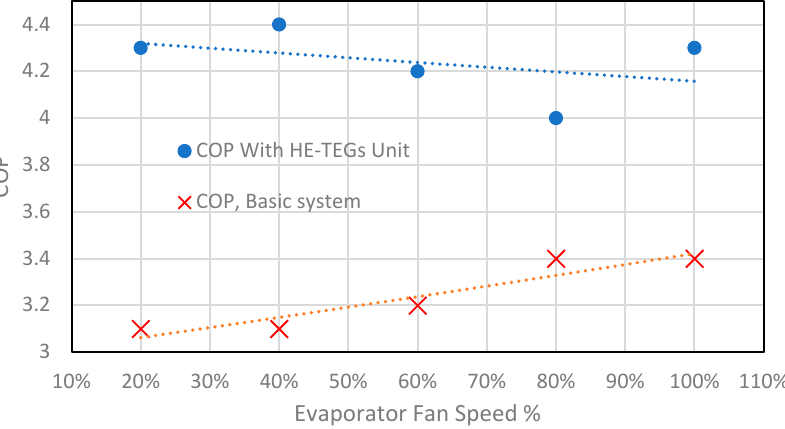
Figure 9. Variation of COP of refrigeration system with evaporator fan speed with and without HE-TEGs unit.